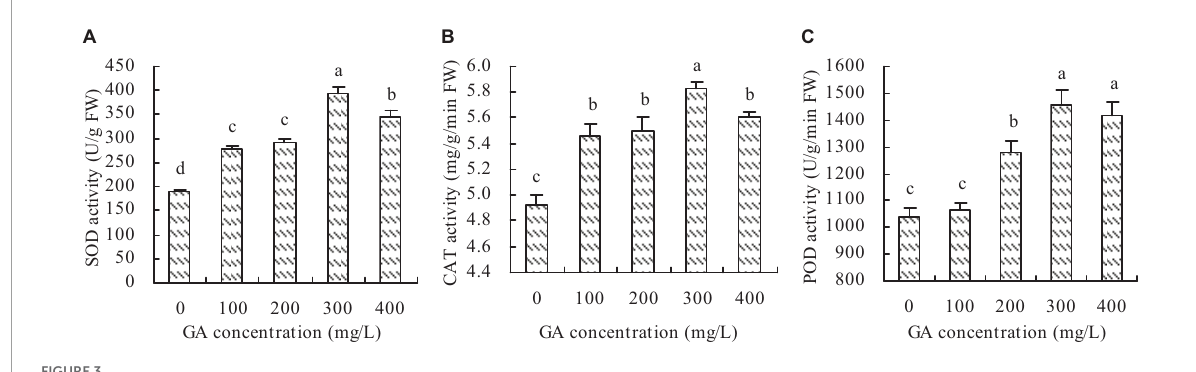
FIGURE3 Antioxidant enzyme activity of C . betacea . (A) SOD activity. (B) CAT activity. (C) POD activity. Different lowercase letters indicate significant differences among the treatments (Duncan’s Multiple Range Test, P < 0.05).